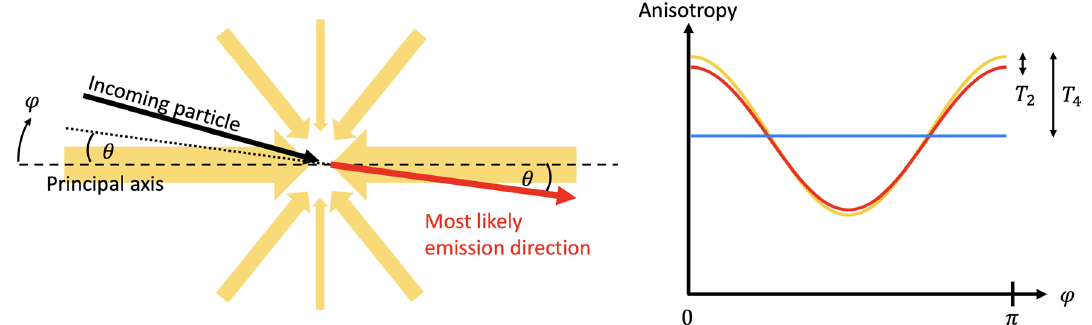
plot) is slightly isotropised relative to the background population (yel- low line) after one coverage time T 2 . Then, by repeatedly updating the background anisotropy with the new walker population anisotropy (i.e.,we“swap”therolesofthewalkerandthebackgroundpopulations) after every T 2 , we will eventually after M ∼ 1 /θ 2 updates end up with a system that is completely isotropised (blue line). The total time this isotropisation process takes is T 4 ∼ M × T 2 (Eq.